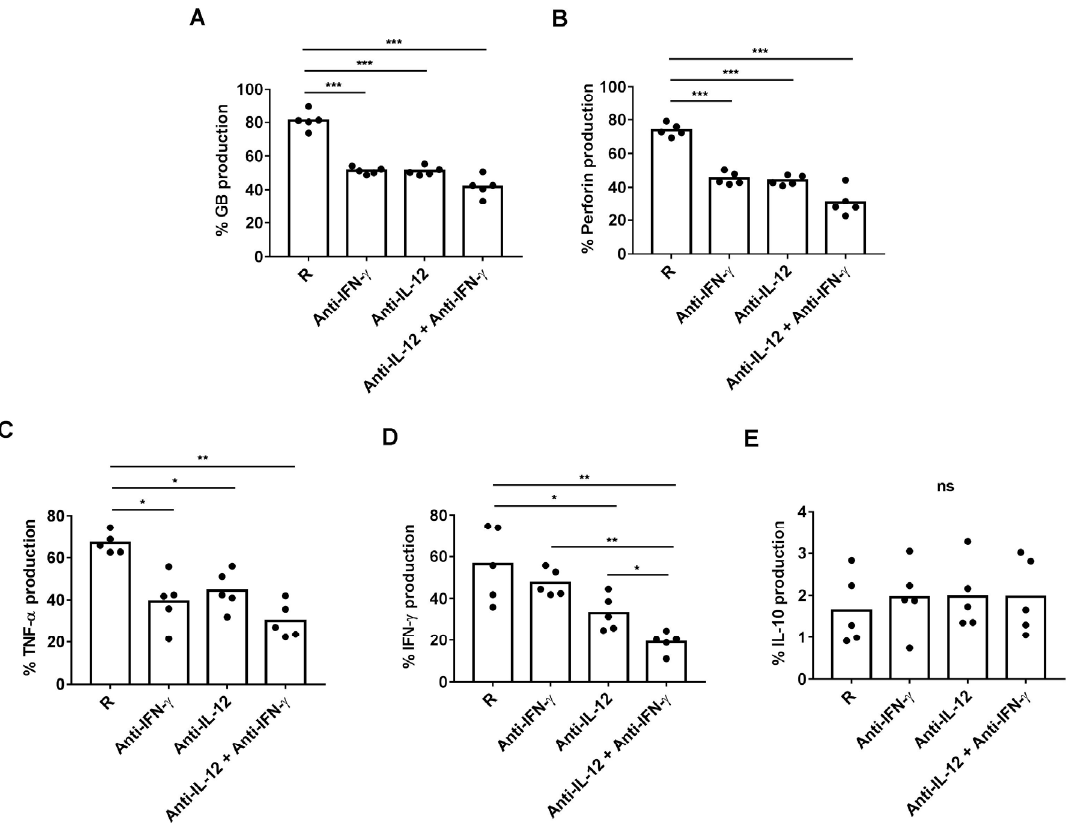
Figure 6. Regulation of cytotoxic granules and intracellular production of cytokines by neutralizing 0.5 ug/mL of anti-IFN- γ ( n = 5) and/or 10 ug/mL of anti-IL-12 ( n = 5) antibodies in a 72 h-culture of HD PBMCs with 25% plasma from R patients. Percentages of CD8+ HLA-DR+ T cells producing intracellular ( A ) granzyme B, ( B ) perforin, ( C ) IFN- γ ( D ) TNF- α ( E ) and IL-10 determined by ELISA. * p < 0.05; *** p <